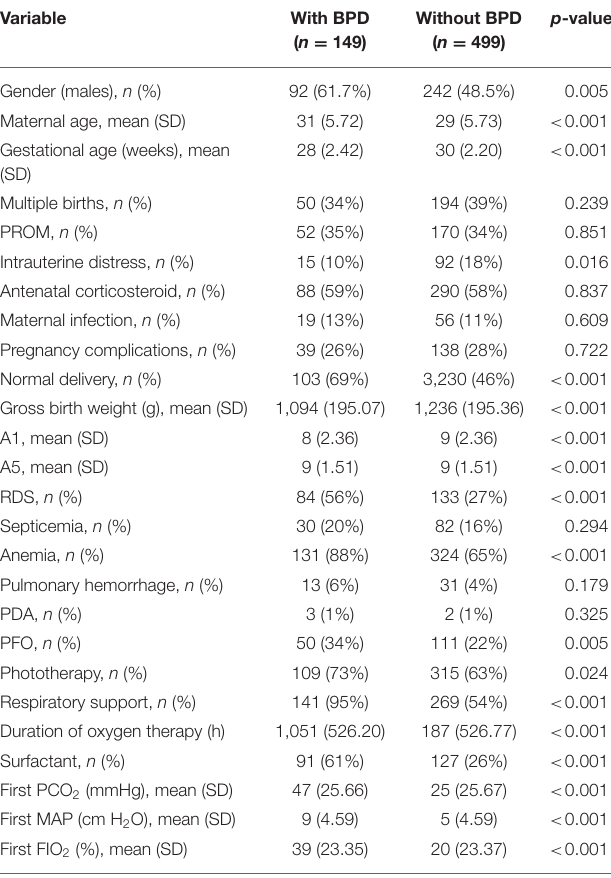
TABLE 1 | Clinical characteristics by BPD